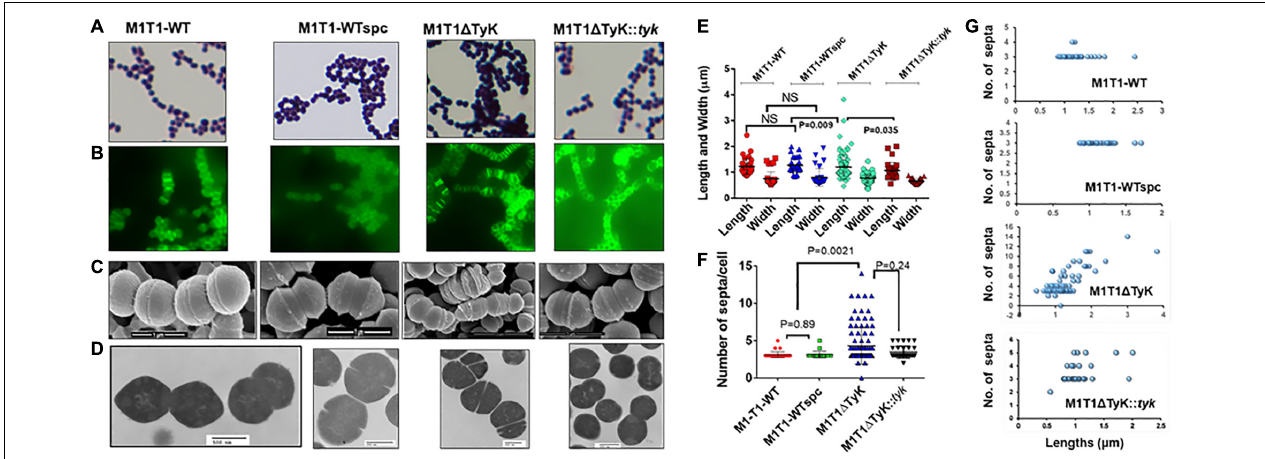
FIGURE 3 | Microscopy of the M1T1-WT, M1T1 (cid:49) TyK mutant, and M1T1 (cid:49) TyK:: tyk complemented Group A Streptococcus (GAS) strains. (A–D) GAS strains as observed by (A) Gram’s stain, (B) Van-Fl stain (Fluorescence microscopy), (C) scanning electron microscopy, and (D) Transmission electron microscopy. Scale bar in electron micrograph as indicated. (E) Quantitative analysis of the lengths and widths and (F) septa of individual GAS strains based on multiple fields. (G) Length vs. the number of septa of each GAS strain’s abnormal and normal individual bacteria based on multiple microscopic fields scanned during scanning electron microscopy. Scattered plots with horizontal bars show the median size in µ m ± S.D. as determined using GraphPad Prism 6. p < 0.05 was treated as a significant difference and determined using non-parametric unpaired Student’s t